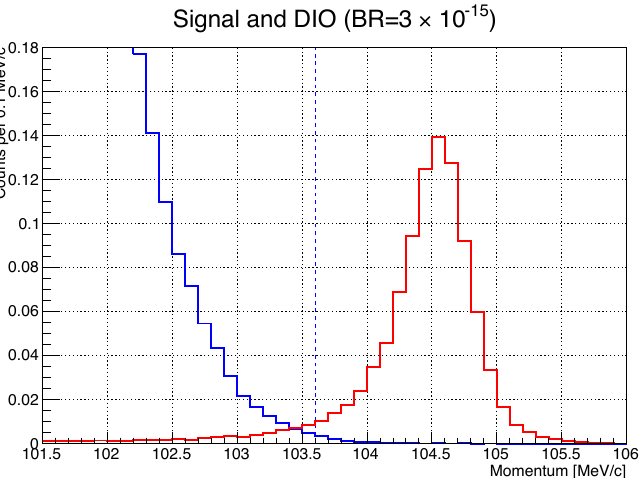
Figure 3. Simulated electron momentum distributions of the µ - e conversion signal (red) and the decay-in-orbit events (blue), assuming a branching ratio of 3 × 10 − 15 in COMET Phase-I. The vertical scale is normalized such that the integral of the signal is equal to one